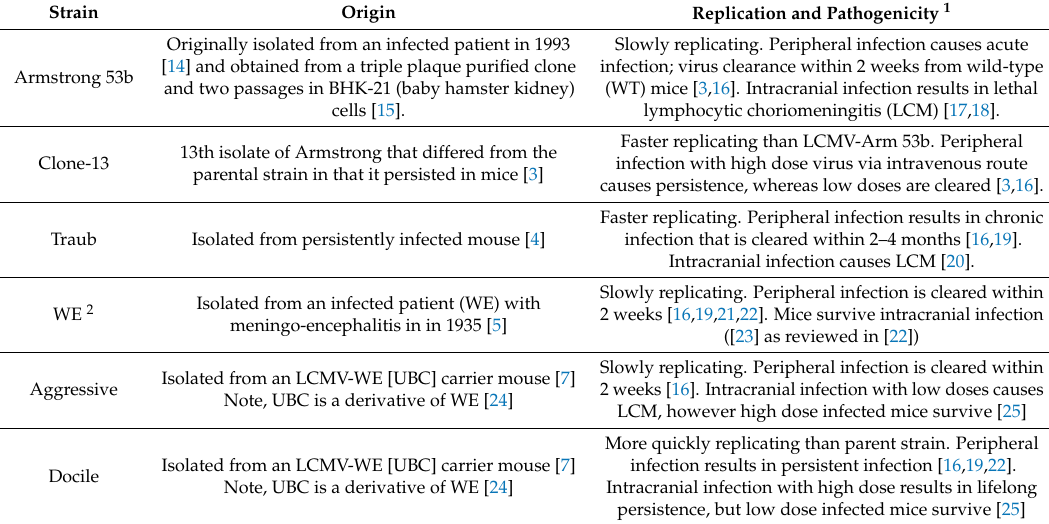
Table 1. Origin and outcome of infection of the six commonly used lymphocytic choriomeningitis virus (LCMV)